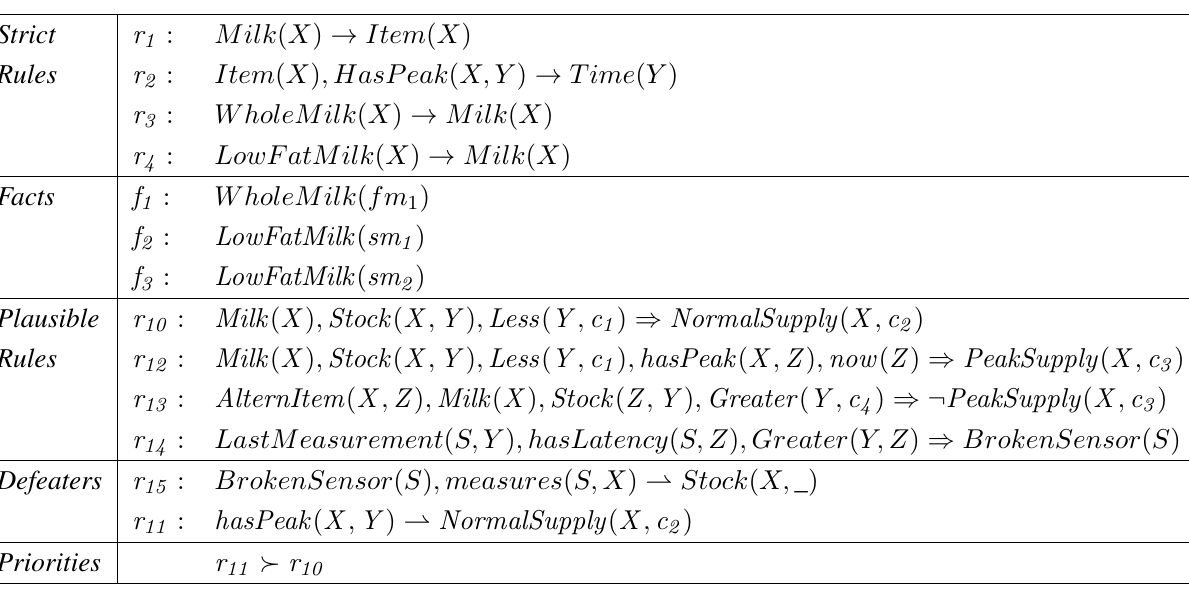
Figure 7. Plausible knowledge